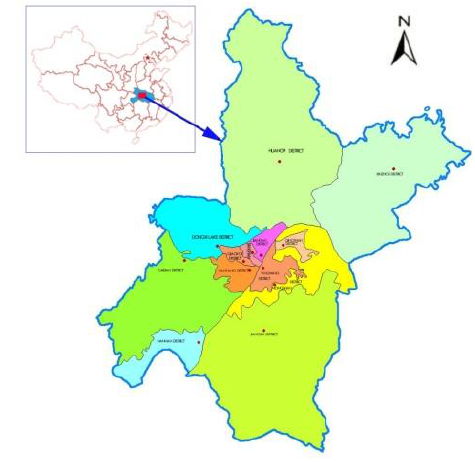
Figure 4.Study area Wuhan in China.